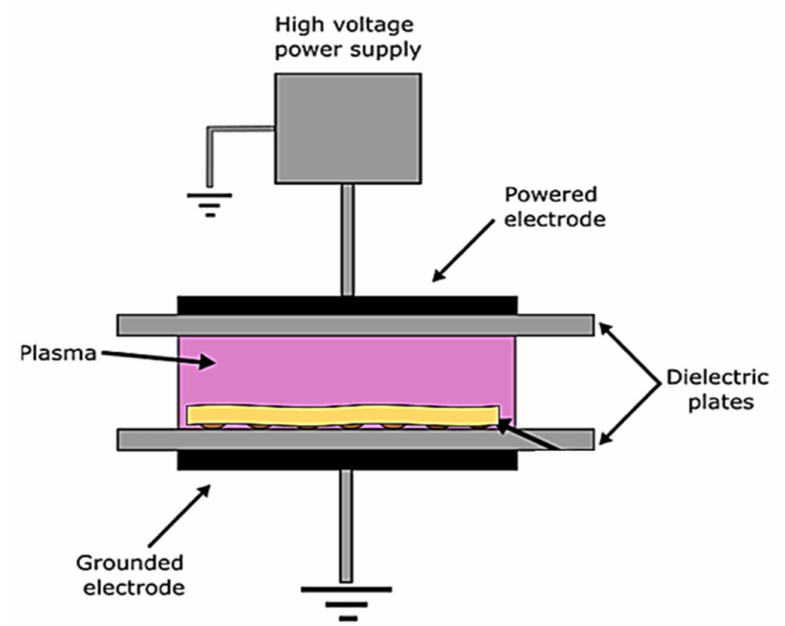
Figure 1. Schematic diagram of Dielectric Barrier Discharge (DBD) for CP treatment